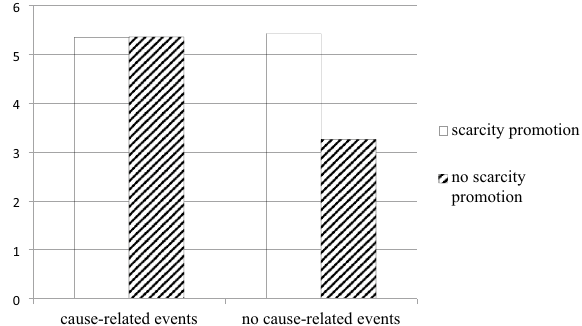
Figure 2. Interaction effect of SP and CRE on